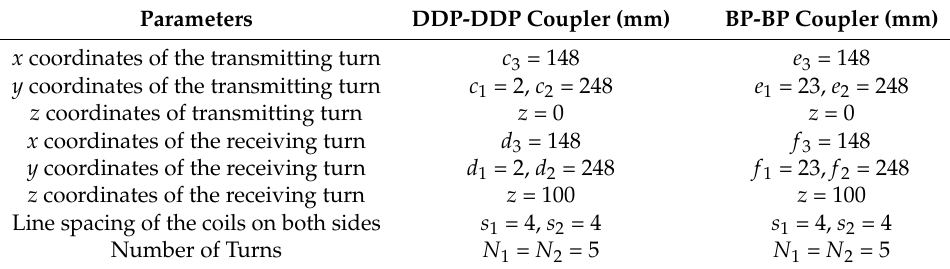
Table 1. Parameters of the analytical models for the two polarized couplers.